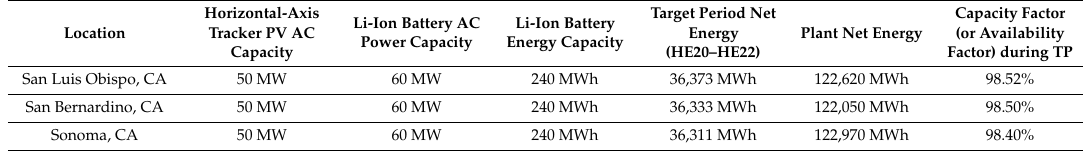
Table 3. Simulation results for PVS in 3 di ff erent locations across